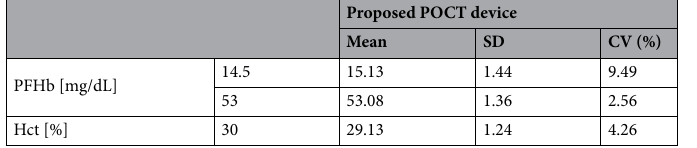
Table 2. Precision results of the proposed POCT device. Each blood sample was measured repeatedly three times, and the SD and CV were